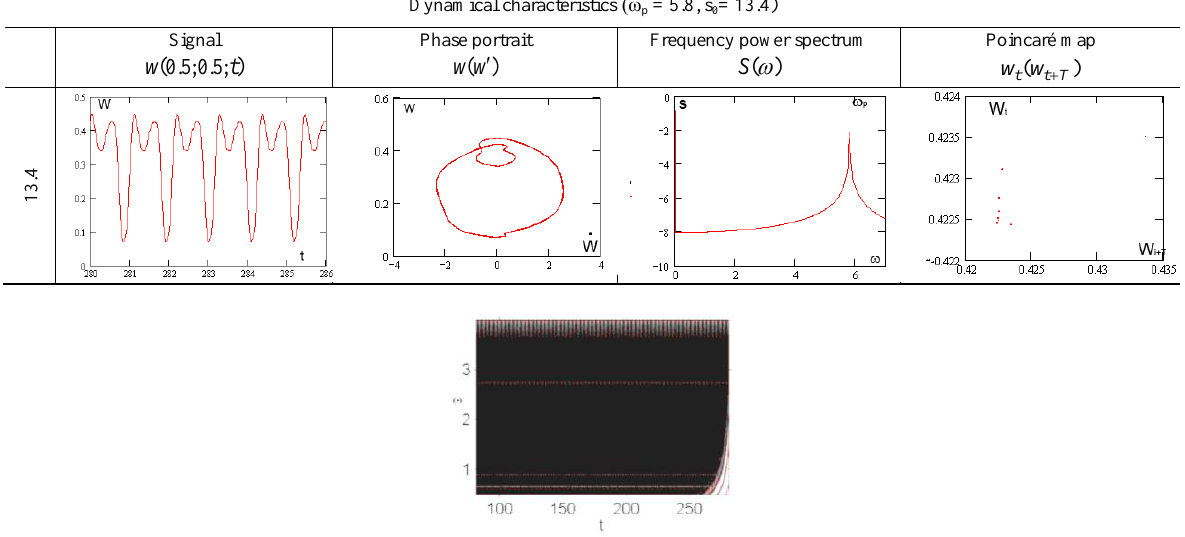
Fig. 5. Wavelet spectrum corresponding to the data of Table